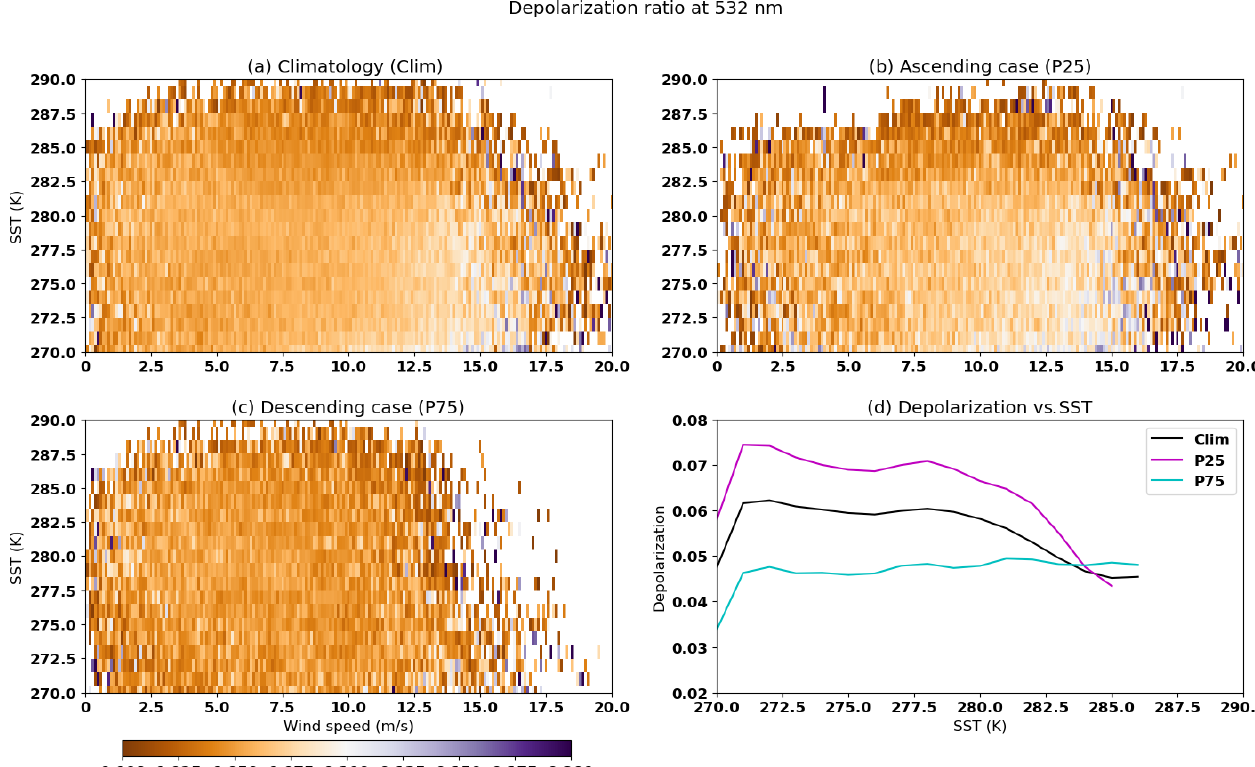
Figure 5. The same as Fig. 4 but for the total linear depolarization ratio (532nm) as a function of surface wind speed and temperature.